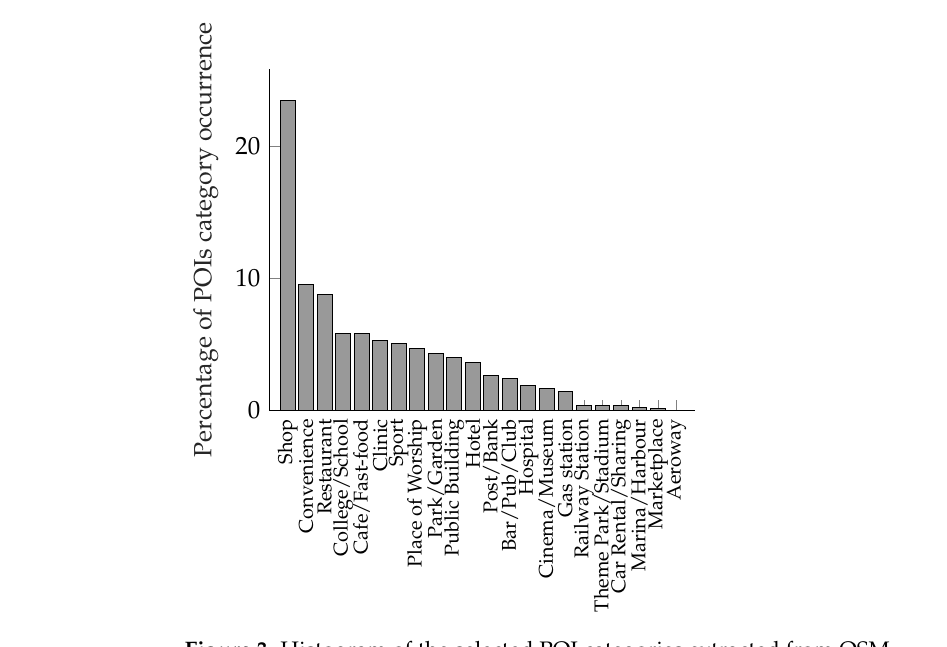
Figure 3. Histogram of the selected POI categories extracted from